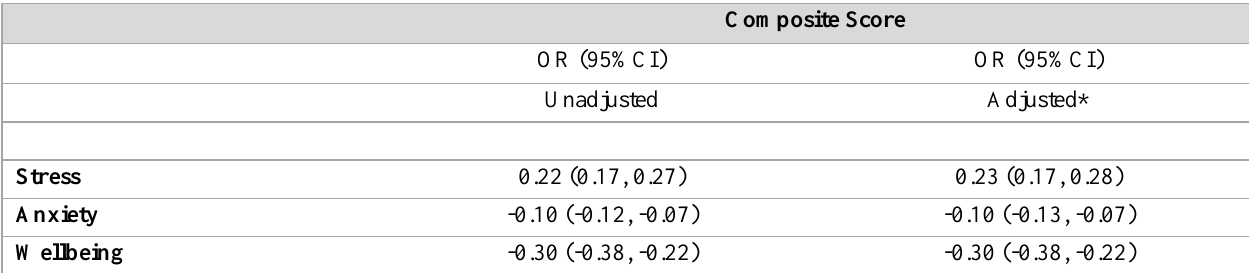
Unadjusted and Adjusted Associations Between Baseline Stress, Anxiety, and Psychological Wellbeing Scores and Composite Online Learning